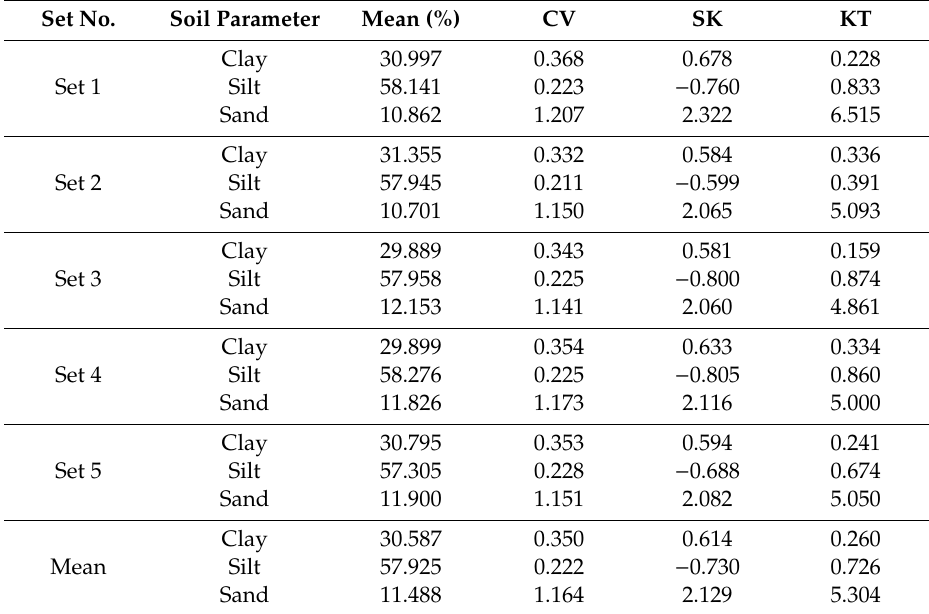
Table 3. Descriptive statistics of random training sample sets.